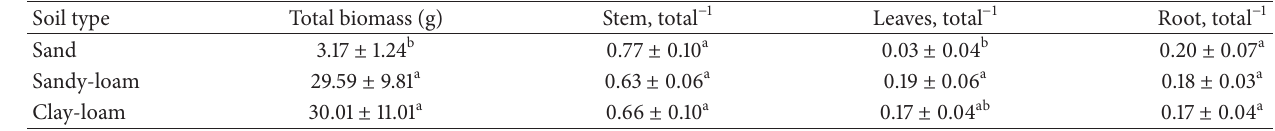
Table 3: Average ± SD dry matter allocation in J. curcas curcas grown in three different soil types.